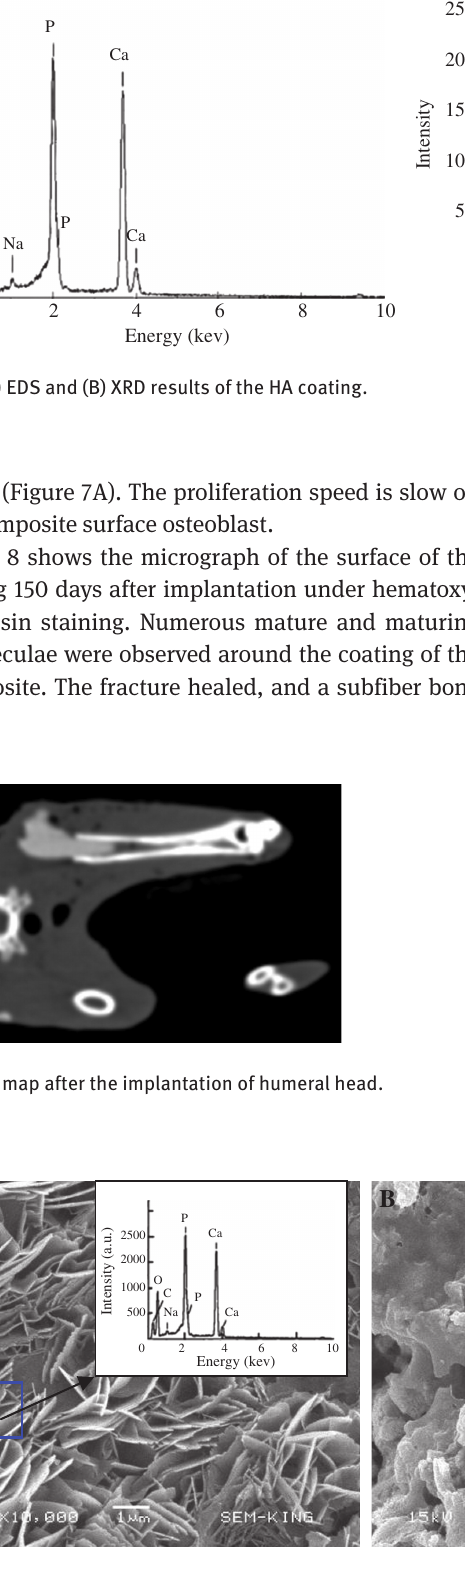
Figure 6 Scanning electron micrograph of the surface of the HA coating at 5 days after implantation and the corresponding EDS: (A) new phosphorites and (B) osteoblasts on the coating